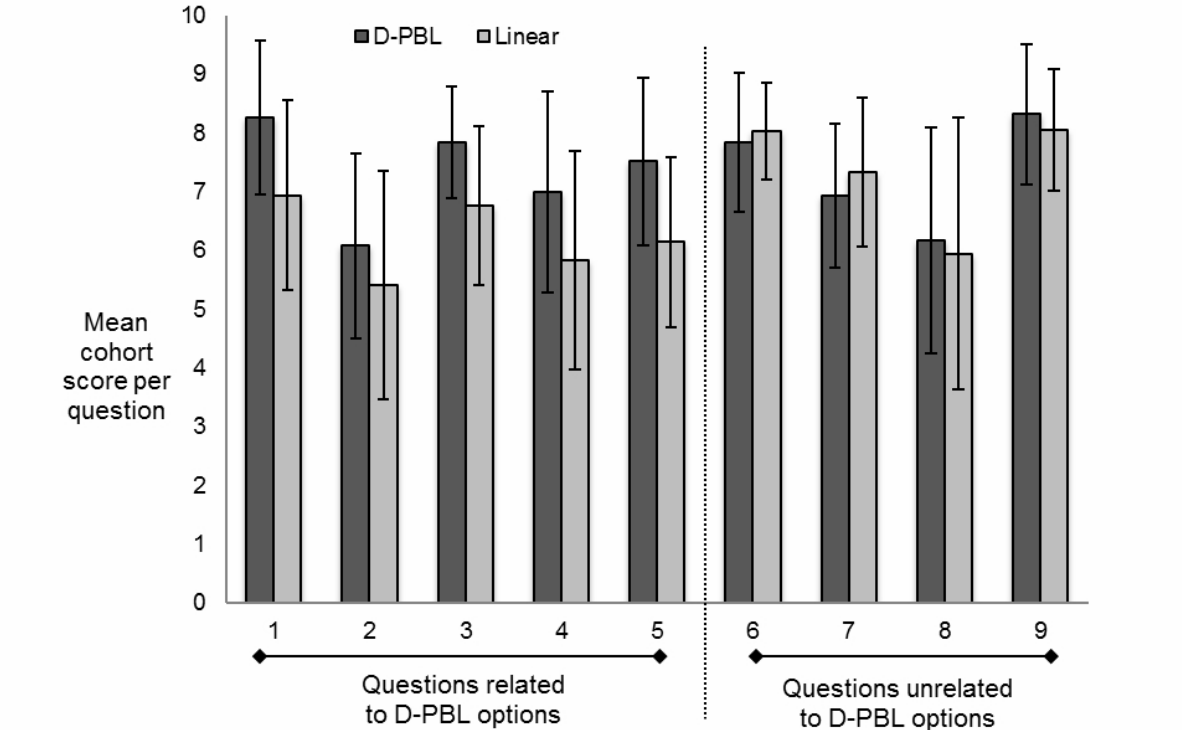
Figure 3. Exam question results analysis. For questions related to D-PBL option points, in each case students who had been part of the D-PBL cohort for that week performed statistically significantly better than those who were part of the linear PBL cohort. For questions unrelated to option points, there was no significant difference between the 2